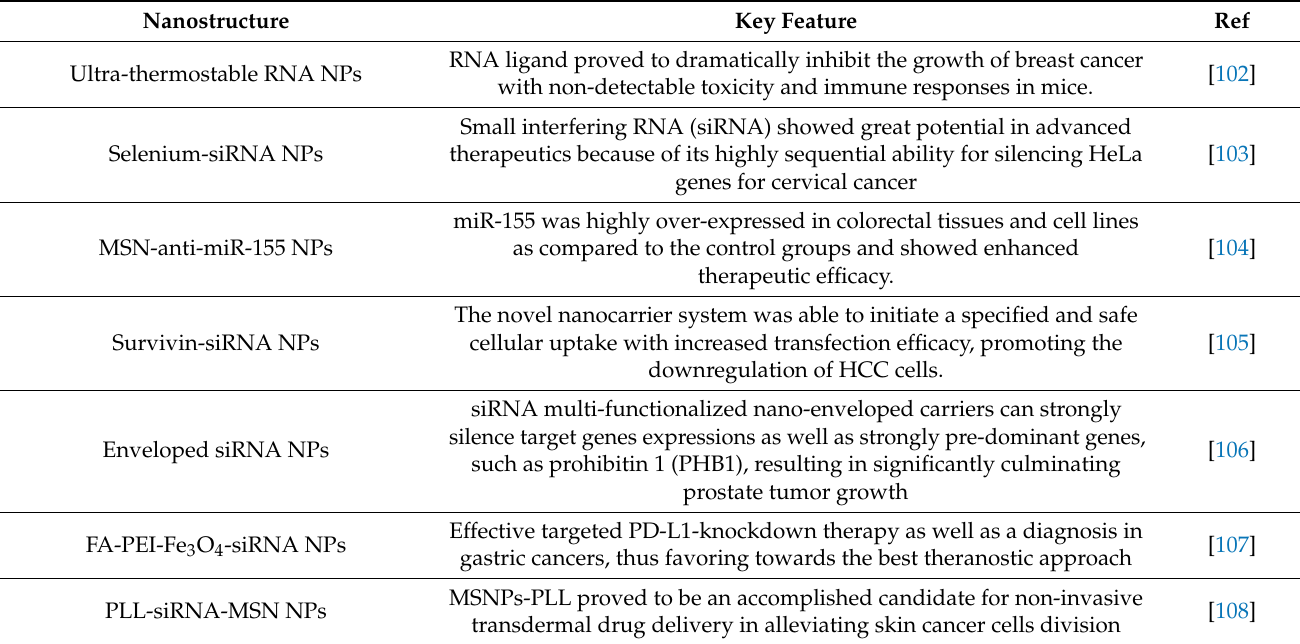
Figure 6. RNA-based nanoparticles various advanced strategies for providing the targeted and efficacious treatment against various metastatic cancers.